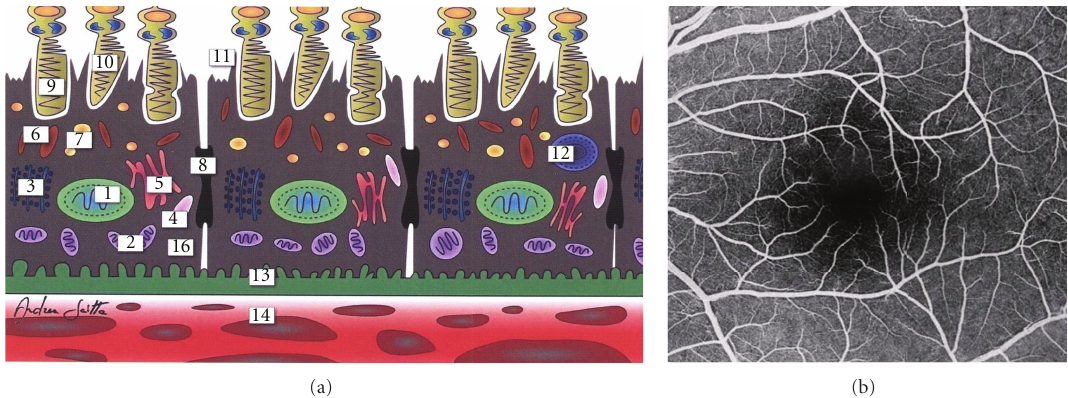
Figure 1: Normal human macula. (a) Schematic cross-sectional illustration of the macular outer segment and, in particular, the cells of the retinal pigment epithelium ((1) nucleus, (2) mitochondria, (3) ribosomes, (4) lysosomes, (5) Golgi apparatus, (6) melanosomes, (7) lipofuscin granules, (8) zonula occludens, (9) photoreceptor (cone), (10) outer segment of cones, (11) phagocytosis of photoreceptorial discs, (12) phagosome, (13) Bruch’s membrane, and (14) choriocapillaris). (b) Fluorescein angiography of the macula with its foveal avascular zone (extracted and modified from